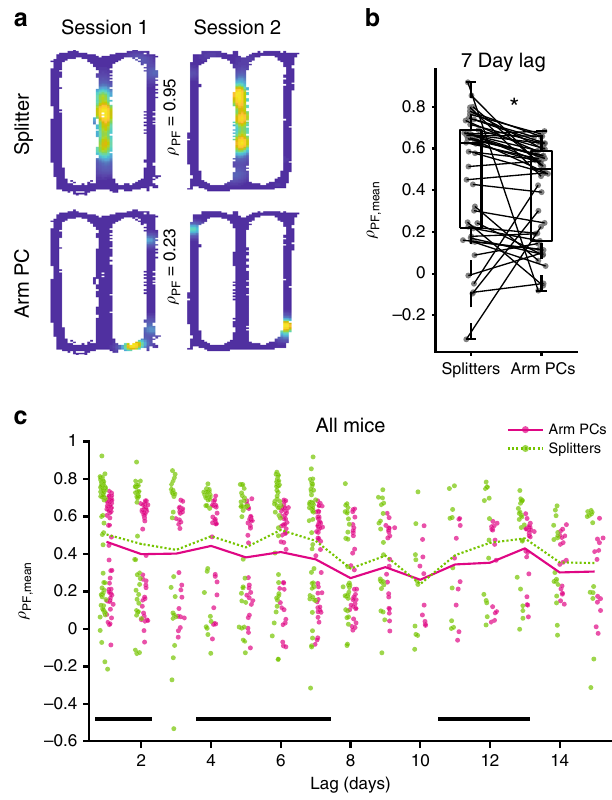
Fig. 5 Splitters maintain more consistent spatial information than place cells. a Example 2D occupancy normalized calcium event maps from the same splitter neuron (top) and arm place cell (bottom) between sessions on adjacent days. The higher Spearman correlation between splitter neuron event maps indicates more consistent spatial activity. Event maps were smoothed with a Gaussian fi lter ( σ = 2.5 cm). b Mean spatial correlations from smoothed event maps for splitter neurons versus return arm PCs for all sessions seven days apart from all. * p = 9.7 × 10 − 5 , n = 42 session pairs, one-sided signed-rank test. Box plots show median and 1st/3rd quartiles, whiskers extend to 1.5× interquartile range. c Mean spatial correlations for splitter neurons and arm PCs versus lag between sessions for all mice/ sessions. Magenta = arm PCs, green dashed = splitters. Black bars = signi fi cant differences after Holm-Bonferroni correction (15 day lags considered) of one-sided signed-rank test, α = 0.05. See Table 4 for raw p -values at all lags.